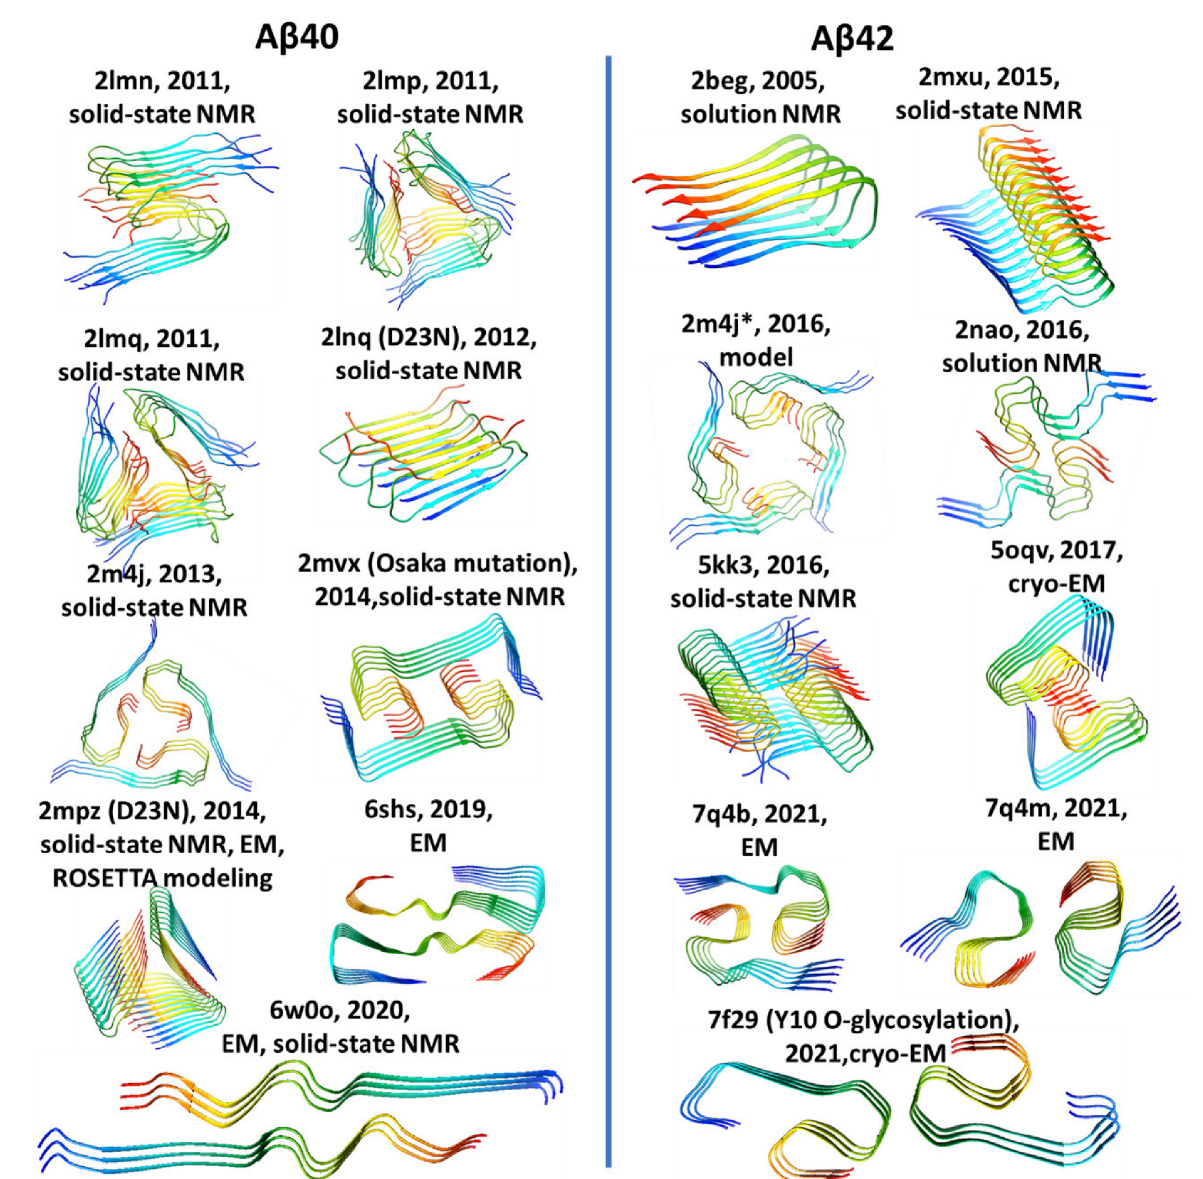
Figure 7. Some structures of A β (1–40) and A β (1–42) fibrils from the Protein Data Bank. The asterisk denotes the following: a trimer was taken from structure 2m4j and structure 2m4j* was built on its basis. A β (1–40) (2lmn—[39], 2lmp and 2lmq—[40], 2lnq—[41], 2m4j—[42], 2mvx—[43], 2mpz—[44], 6shs—[35], 6w0o—[36]). A β 42 (2beg—[45], 2mxu—[46], 2nao—[47], 5kk3—[48], 5oqv—[32],